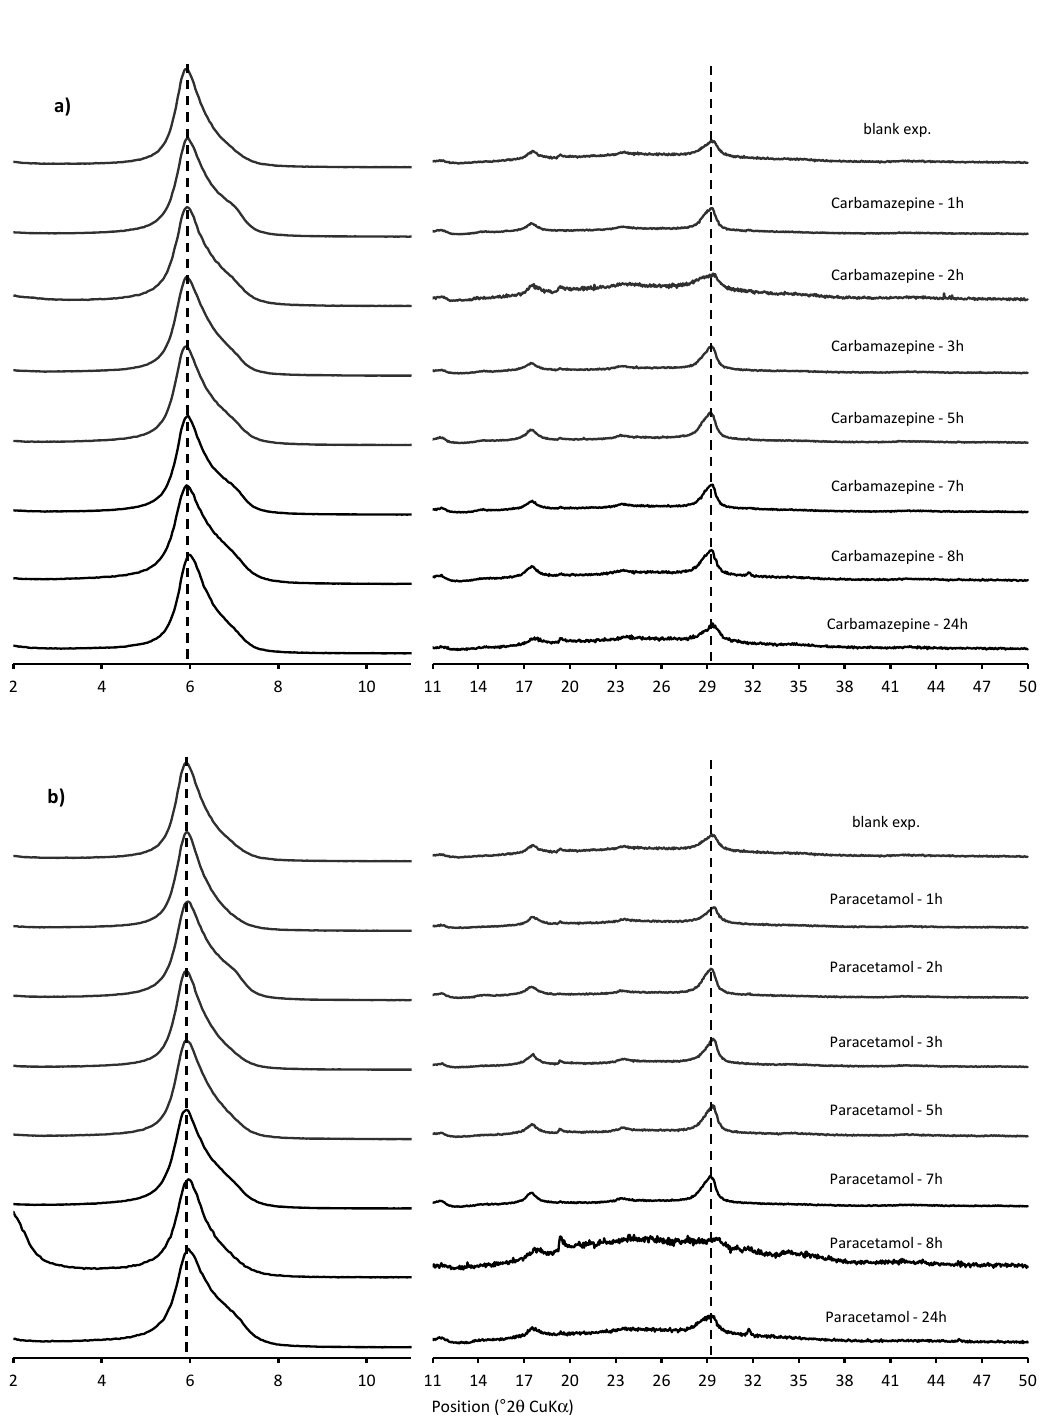
Figure 2. X-ray diffraction patterns of saponite (Sap) contacted with ( a ) carbamazepine and ( b ) paracetamol for different times (see text for details). Exposure time to organic contaminants increases from top (blank—no contact) to bottom. Dashed lines indicate the position of diffraction lines typical for bi-hydrated smectites (14.9 and 3.05 Å).